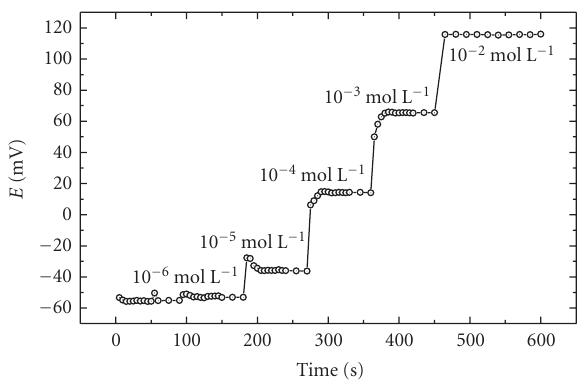
Figure 2: Potentiometric dynamic response of ramipril- phosphomolibdate membrane electrode.